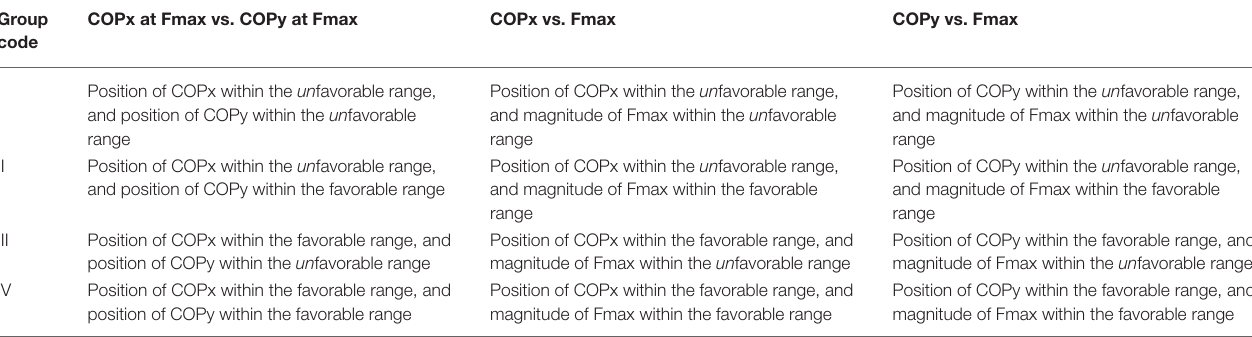
TABLE 2 | Combinations of two parameters and their group code used in Figures 7 – 9 , as well as in Figure 10 (combination of three parameters); COPx, center of pressure in x-direction; COPy, center of pressure in y-direction; Fmax, maximum impact force. Group